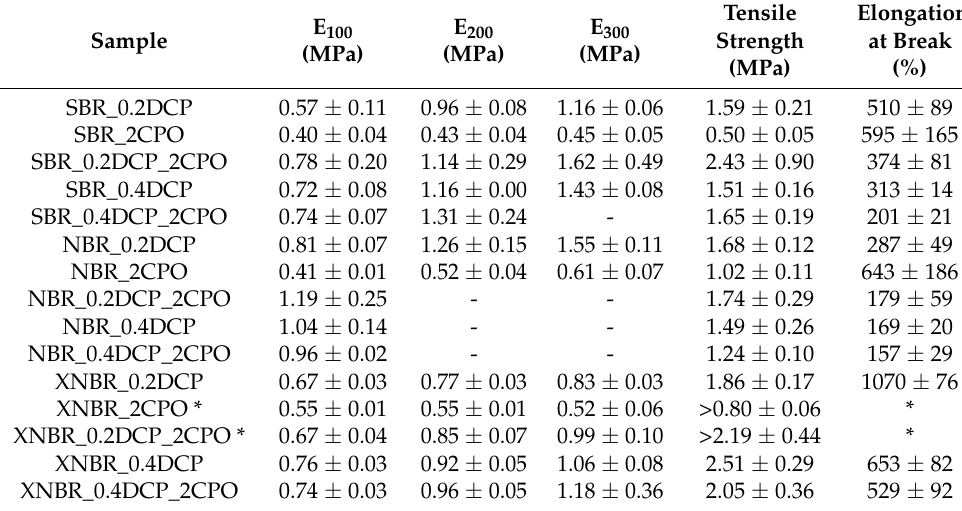
Table 4. Tensile strength and relative elongation at break of the rubber samples tested.